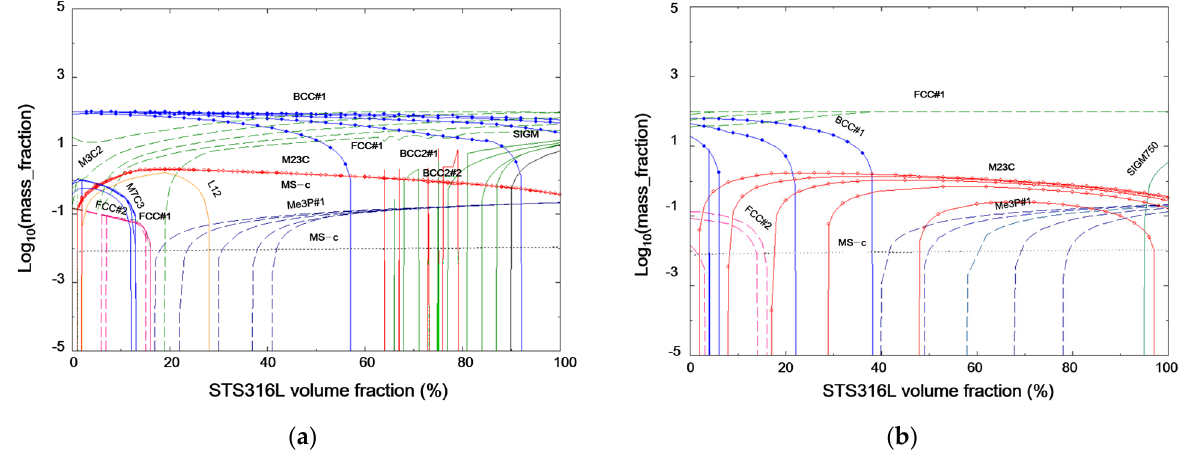
Figure 12. Thermodynamic equilibrium phase diagram depending on fraction between P21 and STS316L and temperature: ( a ) temperature range 500~700 °C; ( b ) temperature range 750~950 °C.